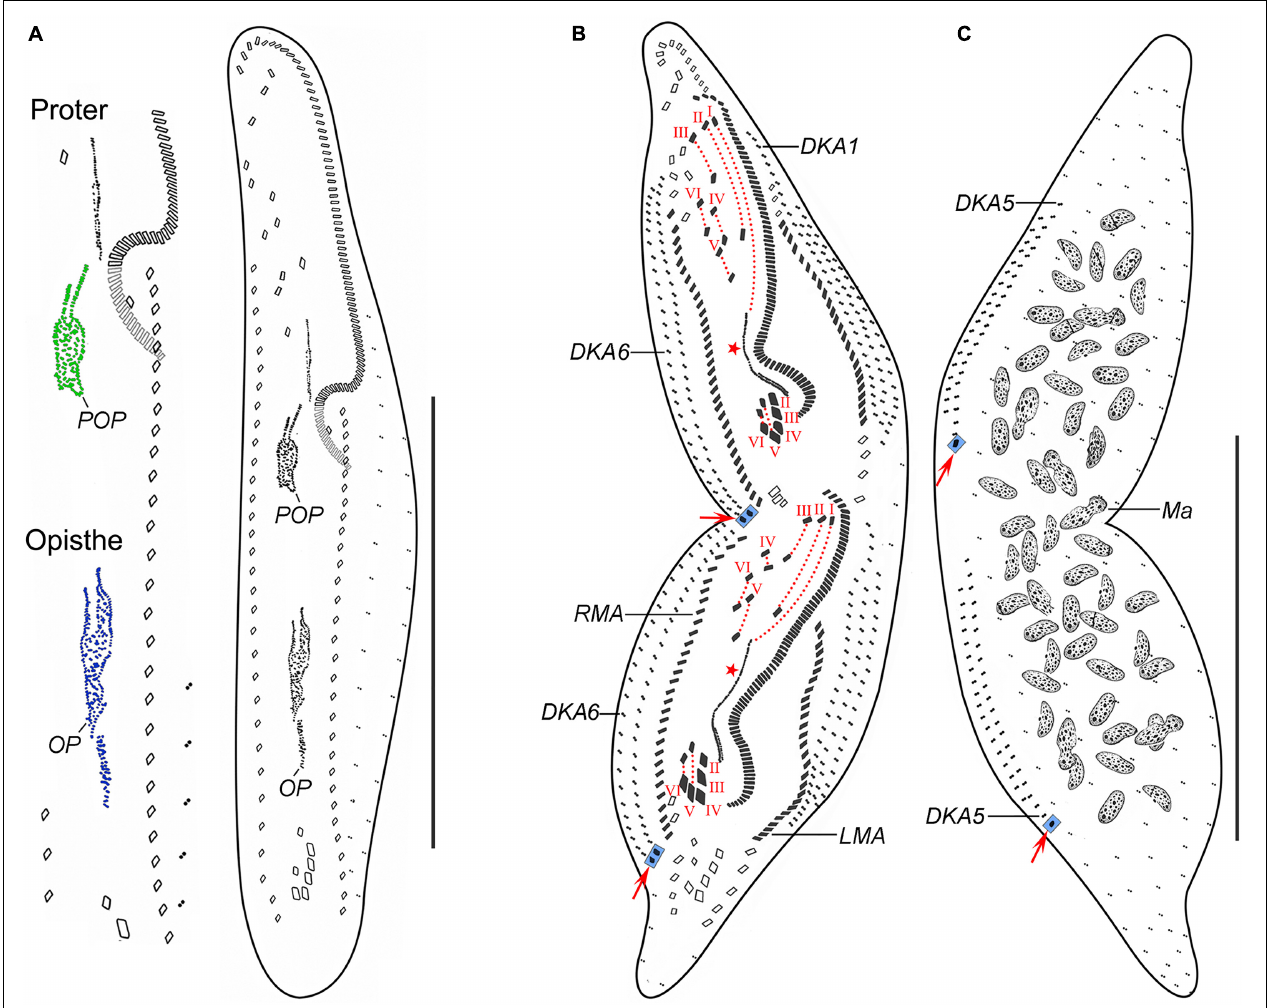
FIGURE 3 | Trachelostyla multinucleata spec. nov., an early (A) and a late (B,C) divider after protargol impregnation. (A) Ventral view, showing the formation of oral primordia in the proter and the opisthe. (B,C) Ventral (B) and dorsal (C) views showing the cirri, dorsal kineties and cirral migration pattern as well as the nuclear apparatus. Red arrows mark caudal cirri, and red asterisks denote the undulating membranes anlagen. Frontal-ventral-transverse cirri originating from the same anlagen are connected by red dotted lines. DKA1, 5, 6, the first, fifth, and sixth dorsal kinety anlage; LMA, left marginal cirral anlage; Ma, macronuclear nodules; OP, opisthe’s oral primordium; POP, proter’s oral primordium; RMA, right marginal cirral anlage; I–VI, frontal-ventral-transverse cirri originating from anlagen I–VI. Scale bars = 150 µ m (A–C) .